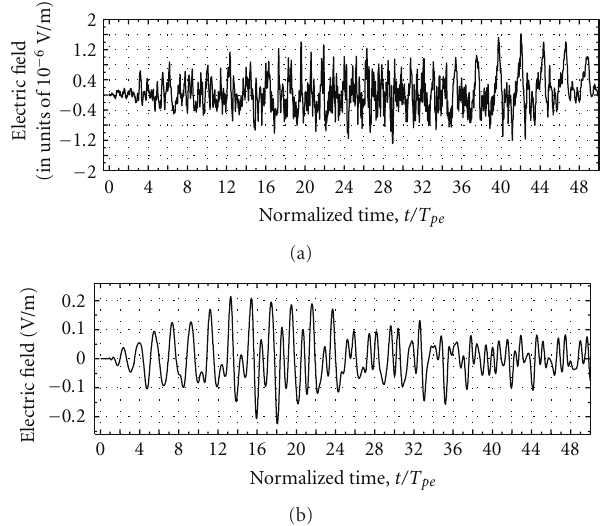
Figure 4: The time variations of one component of the electric field, namely, E x , lying in the plane perpendicular to the magnetic field, calculated at the center of the simulation region for the first situation with the start from the completely electrically neutral state (a), also E x , calculated at the point, displaced from the center of the simulation region in the X direction for a distance of sixteen Debye ), for the second situation when the initially created lengths (16 · λ 0 D e irregularity was studied (b). The electric field components are given in units of 10 − 6 V/m in (a) and in V/m in the (b). The normalized time, t/T pe , that is, the time in units of the equilibrium period of Langmuir oscillations of electrons, T pe , is shown on the abscissa.